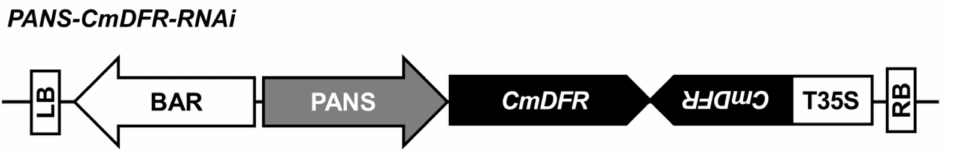
Figure 1. Schematic representation of the binary vector used for silencing CmDFR through RNA interference under the tobacco ( Nicotiana tabacum ) floral-specific promoter PANS . LB: left border, RB: right border, BAR: bialaphos resistance gene.